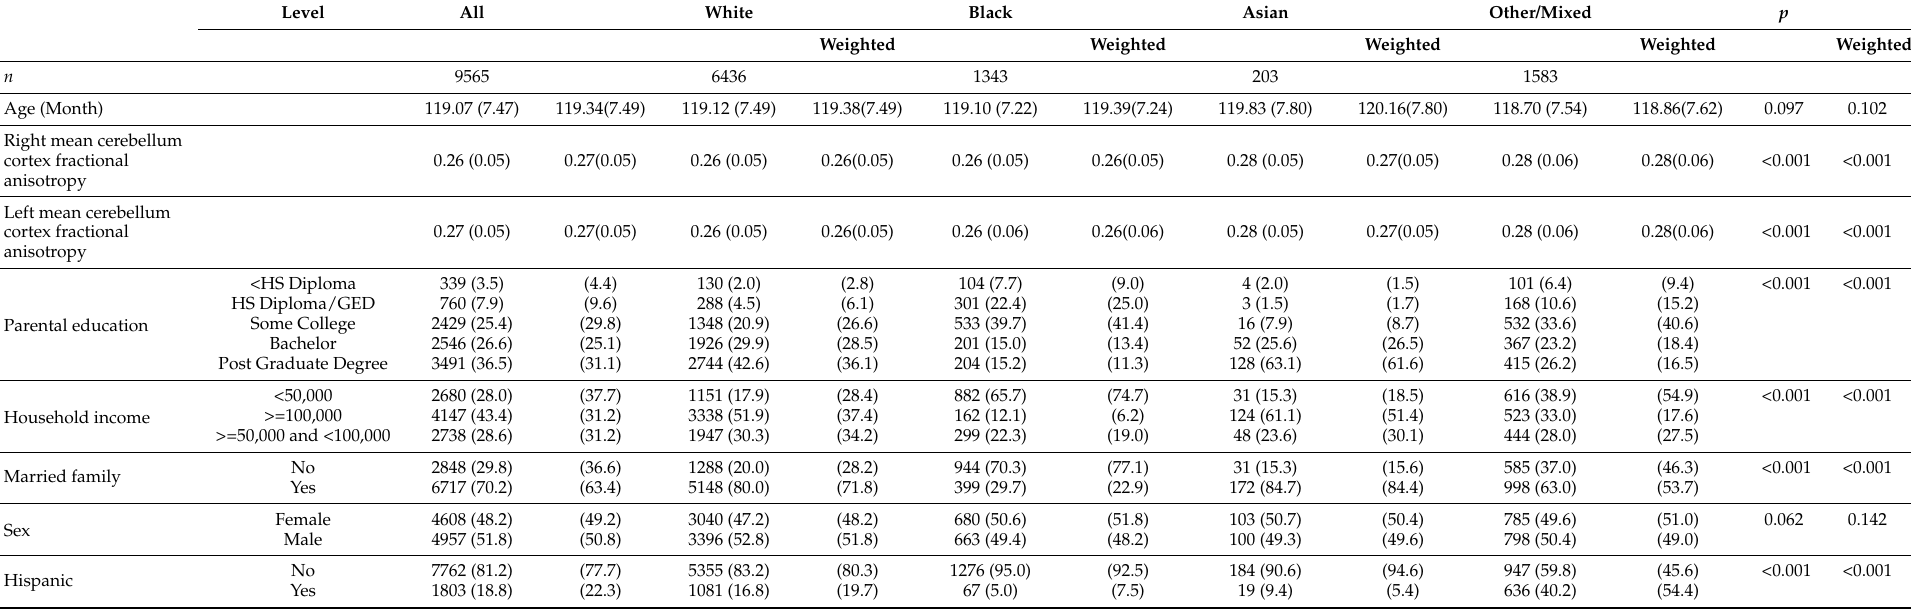
Outcomes: right and left cerebellum cortex fractional